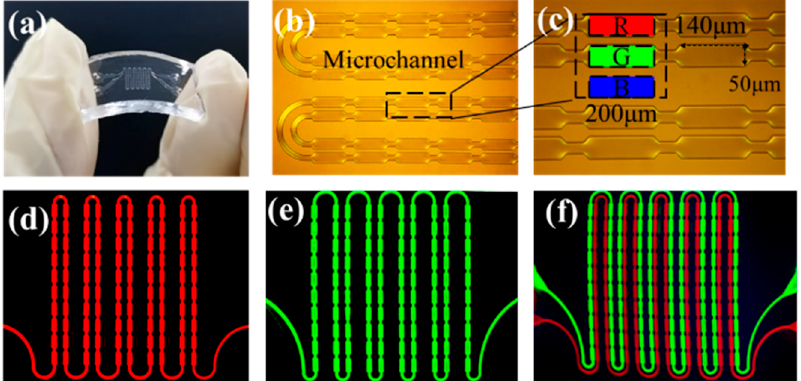
Figure 4. ( a ) Image of a physical flexible chip bending. ( b ) Flexible chip microchannels and ( c ) par- tially enlarged view of microchannels. ( d ) Red pixel array, ( e ) green pixel array, and ( f ) two-color pixel array.